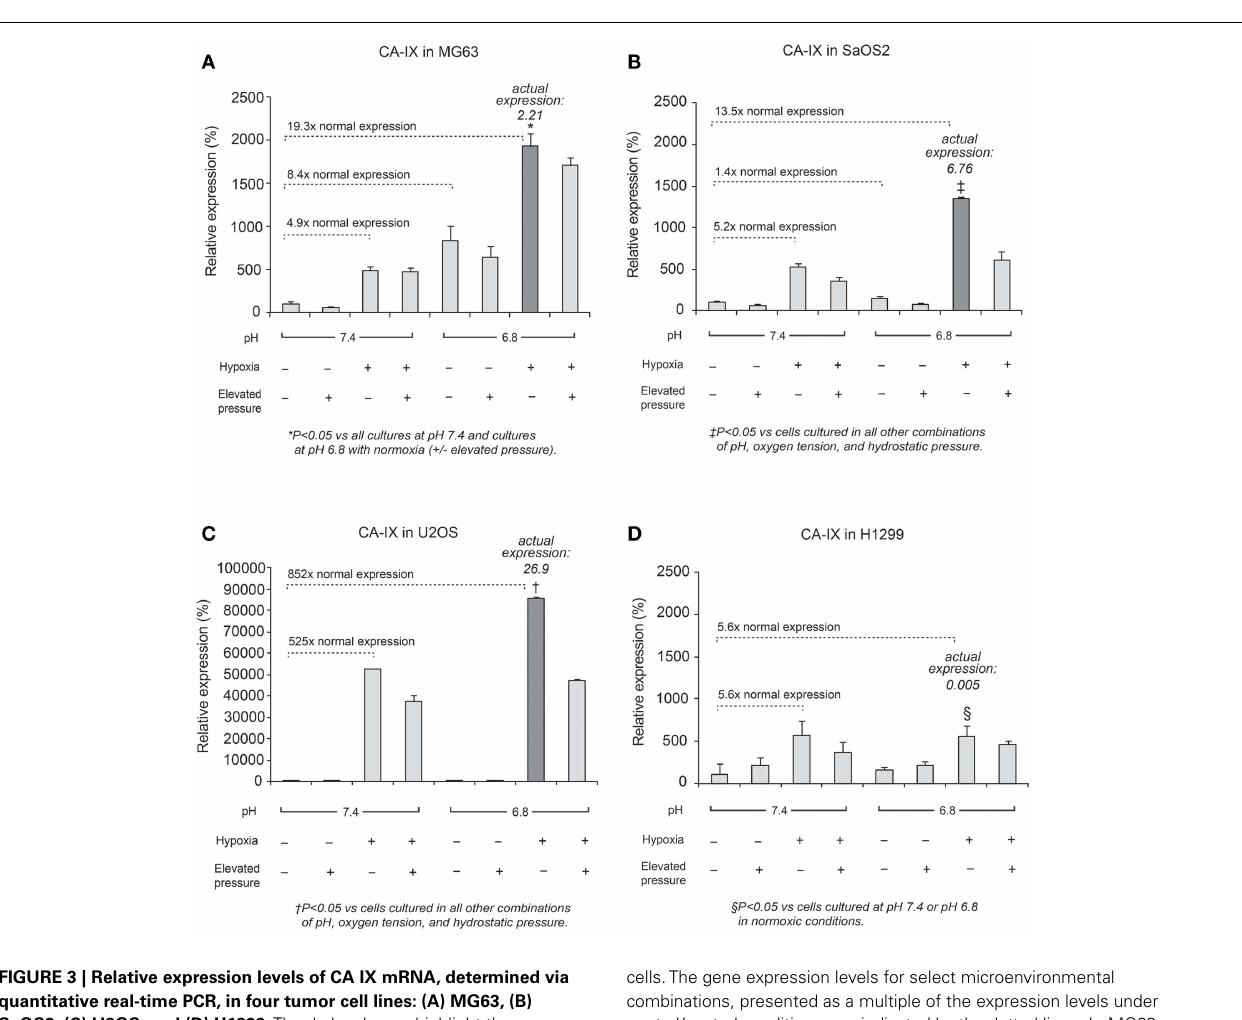
FIGURE 3 | Relative expression levels of CA IX mRNA, determined via quantitative real-time PCR, in four tumor cell lines: (A) MG63, (B) SaOS2, (C) U2OS, and (D) H1299 .The dark columns highlight the acidic-hypoxic-non-pressurized conditions, which elicited the highest expression of CA IX in the osteosarcoma cell lines.The italic number in each panel represents the real CA IX expression levels (normalized to HPRT ) in these growth conditions.The normalized CA IX expression level in U2OS (26.9) was the highest among osteosarcoma cell lines. CA IX expression in H1299 (0.005) was very weak compared with osteosarcoma